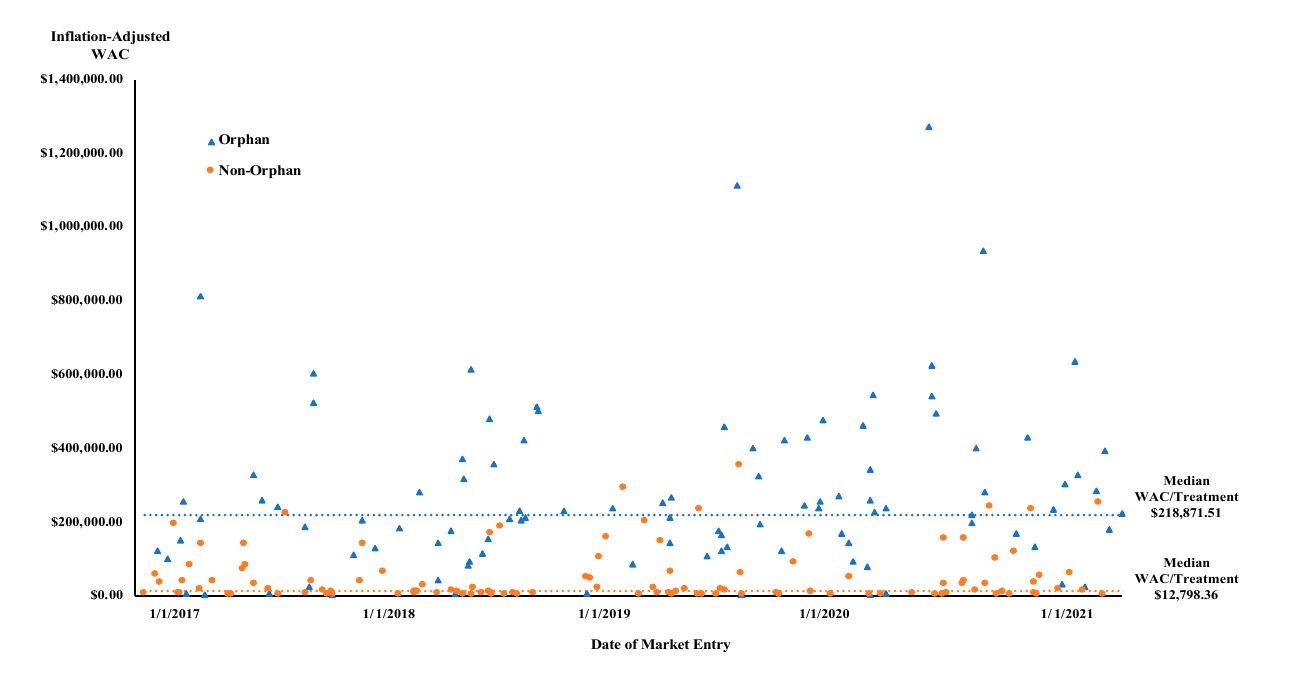
Figure 1. New drugs treatment cost at US market entry (USD 2021) and median WAC. However, the difference in the median treatment cost for non-orphan drugs marketed by US companies and those marketed by companies from other countries was insignificant (USD 9483.82 vs. USD 15,834.14, p = 0.262; Table 1). The median treatment cost for first-in-class approved orphan drugs was not statistically significant relative to the median treatment cost for other orphan drugs (USD 239,593.23 vs. USD 206,176.28, p = 0.322). The median treatment cost for orphan drugs that received a priority review was not significantly different from the cost for orphan drugs with standard reviews (USD 233,934.14 vs. USD 142,195.27, p = 0.053). Although orphan drugs intended for treatment had a median treatment cost three times higher than drugs for preventive use, the difference was not statistically significant (USD 230,768.11 vs. USD 71,503.98, p = 0.190). The median treatment cost for non-orphan drugs intended for treatment indication was significantly higher than for drugs for the preventive indication (USD 18,486.88 vs. USD 2311.92, p = 0.047). ment cost for oncology orphan drugs compared to non-orphan drugs (USD 220,832.30